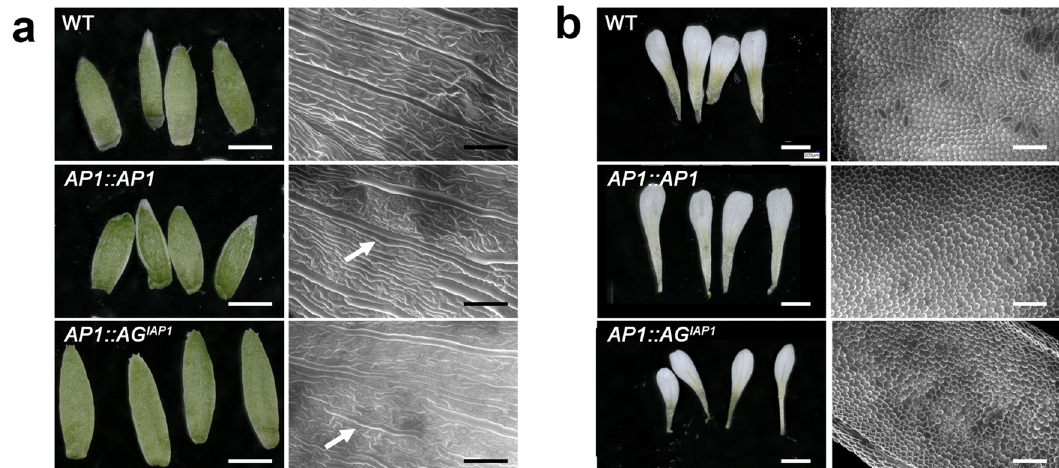
Fig. 7 First and second whorls cell identity are complemented in ap1-7 plants expressing AG IAP1 . First ( a ) and second ( b ) whorl organs were removed from WT, and fl owers from AP1 or AG IAP1 expressing ap1 -7 plants. First whorl organs in AG IAP1 expressing plants are slightly longer compared to WT and AP1 expressing plants ( a , left panel). Second whorl organs in AG IAP1 expressing plants are slightly smaller compared to WT and AP1 expressing plants ( b , left panel). Epidermal cell identity, observed by SEM, shows characteristic WT elongated sepal cells in AP1 and AG IAP1 expressing plants ( a , right panel) and characteristic WT conical cells in petals from AP1 and AG IAP1 expressing plants ( b , right panel). A small number of epidermal cells typical of leaves are also seen in AG IAP1 expressing plants and to a lesser extent in AP1 expressing plants (arrow). Scale bars indicate 100 µ M for SEM images and 1 mm for